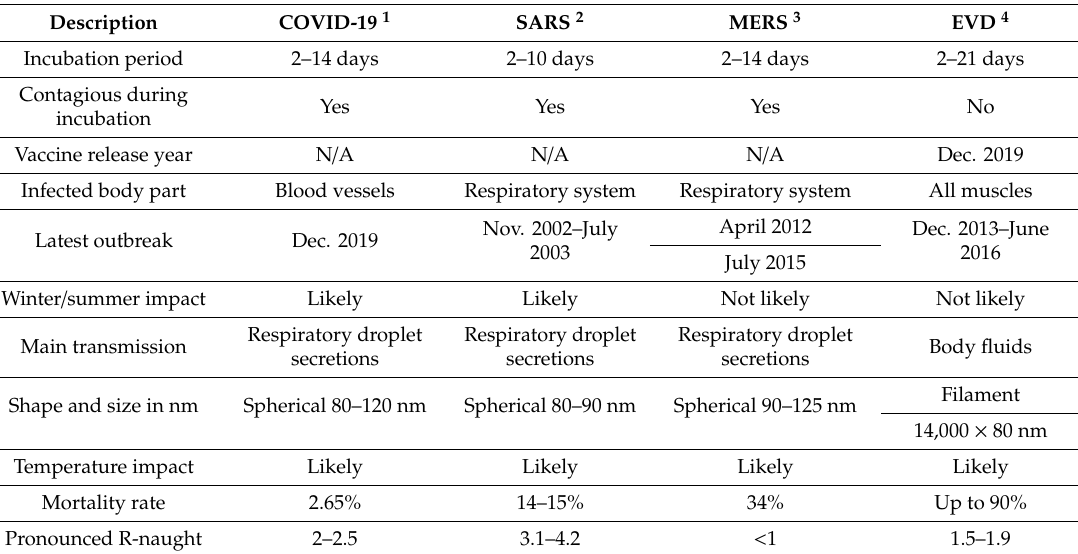
Table 1. Comparison between COVID-19, SARS, MERS, and